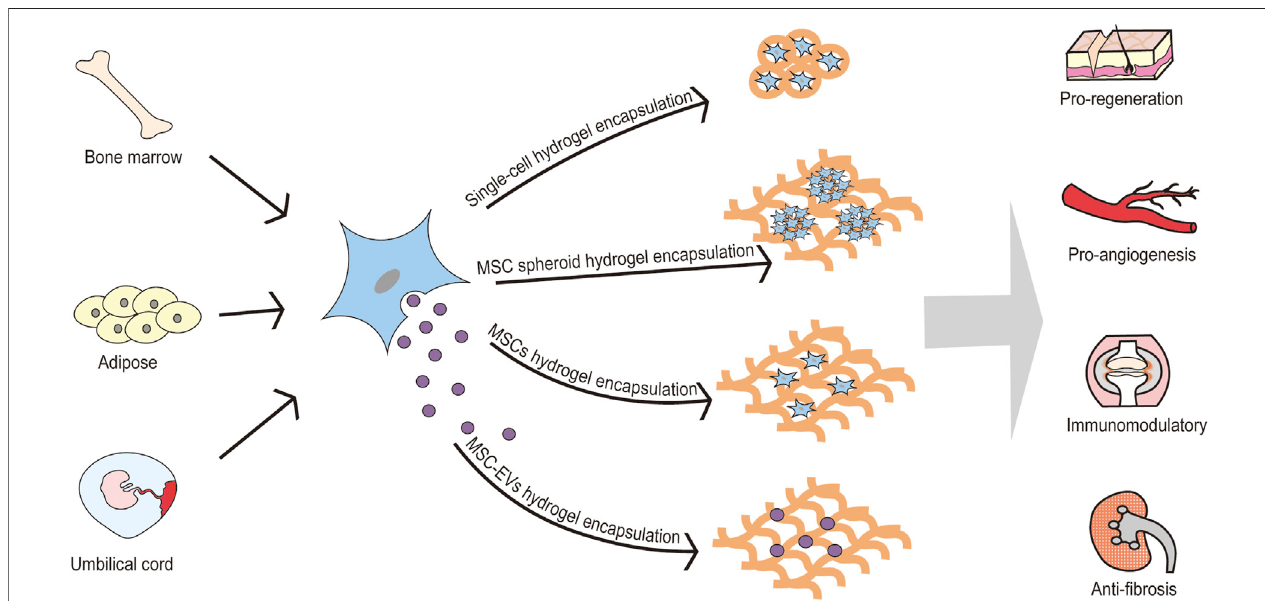
FIGURE1| HydrogelencapsulationmaybringthetreatmentofMSCsand theirsecretome tothenextlevel.MSCsarederivedfromvarious tissues,including bone marrow, adipose, umbilical cord, peripheral blood, etc. MSCs can be encapsulated by hydrogel in various formation (single-cell hydrogel encapsulation, MSC spheroid hydrogelencapsulation,andMSCshydrogelencapsulation).Also,MSC-EVscanbeencapsulatedbyhydrogelforpro-regenerative,pro-angiogenic,immunomodulation and anti- fi brotic effects. MSC: mesenchymal stem cell; MSC-EVs: mesenchymal stem cell-derived extracellular